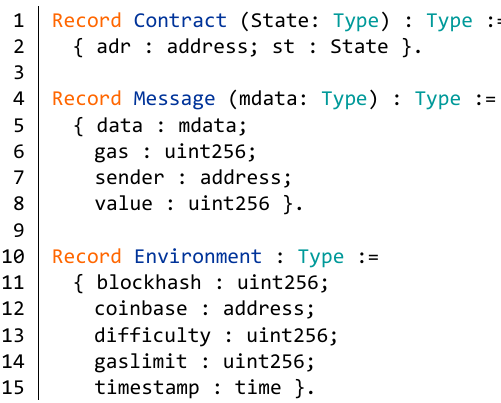
Figure 9. The abstract model of smart contract.